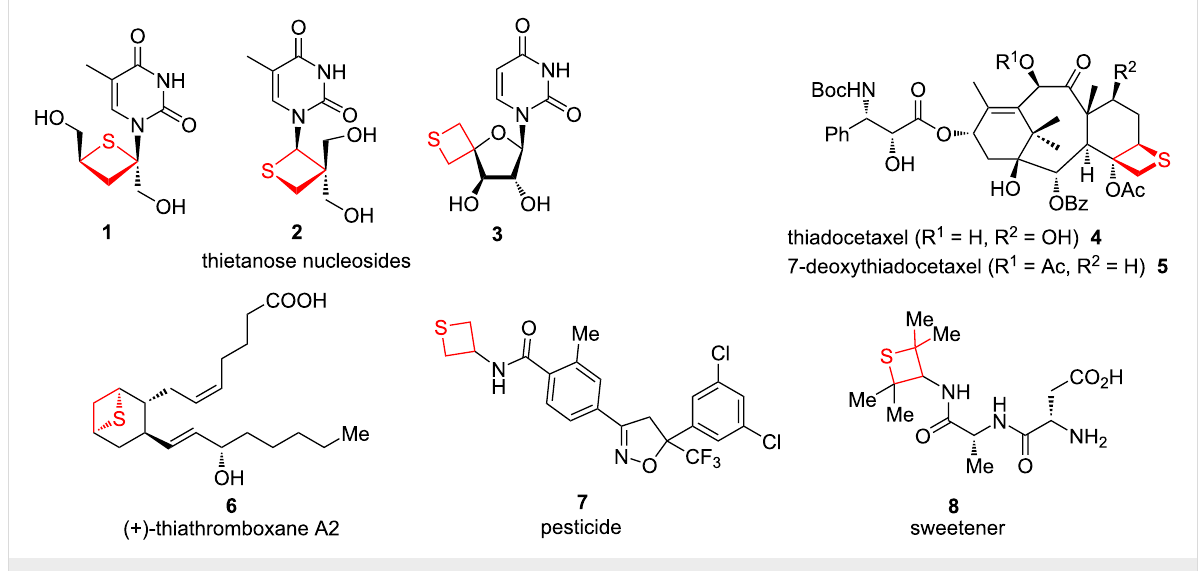
Figure 1: Examples of biologically active thietane-containing molecules.